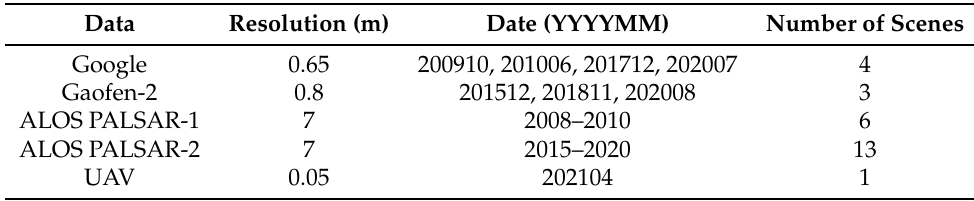
Table 1. Summary of the remotely sensed dataset used in this study. The acquisition dates of ALOS PALSAR-1/2 can be found in Table